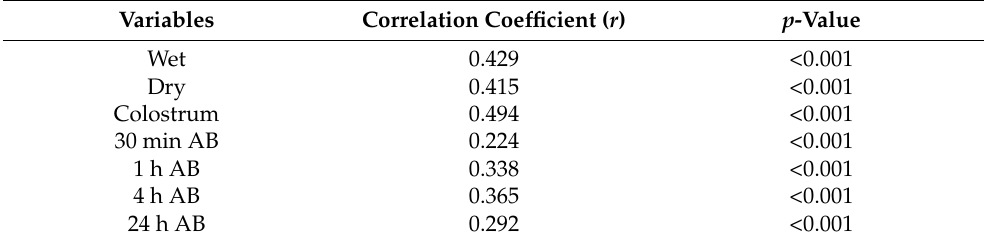
Table 14. Significant correlations between puppies’ weight and their superficial temperature at FPL thermal window.